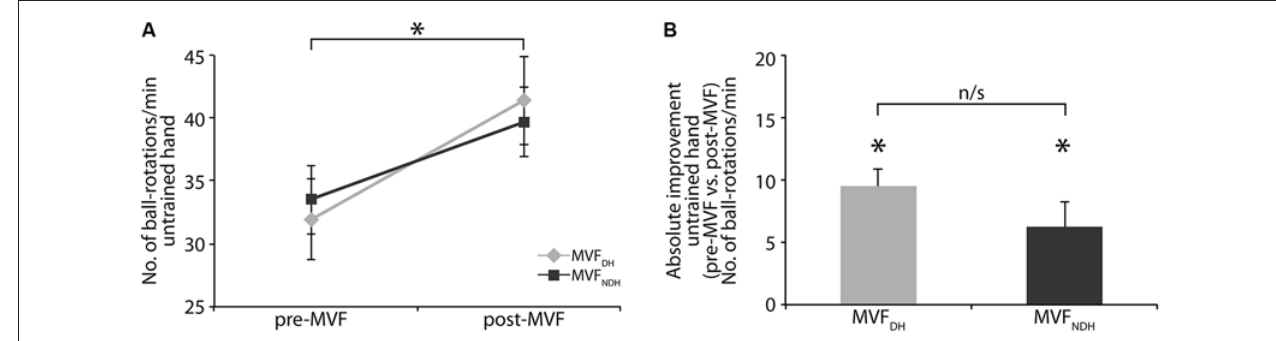
FIGURE 2 | Effect of MVF on motor performance of the untrained hand. (A) Number of ball-rotations/min of the untrained hand before and after MVF. Note that baseline performance of the untrained hand did not differ between groups. (B) Absolute performance improvement of the untrained hand. Both groups improved their performance with the untrained hand significantly. There was no significant difference in absolute performance improvement of the untrained hand between groups. The plot shows mean values, and whiskers represent standard error (SE) values. ∗ P < 0.05; n/s, not significant.